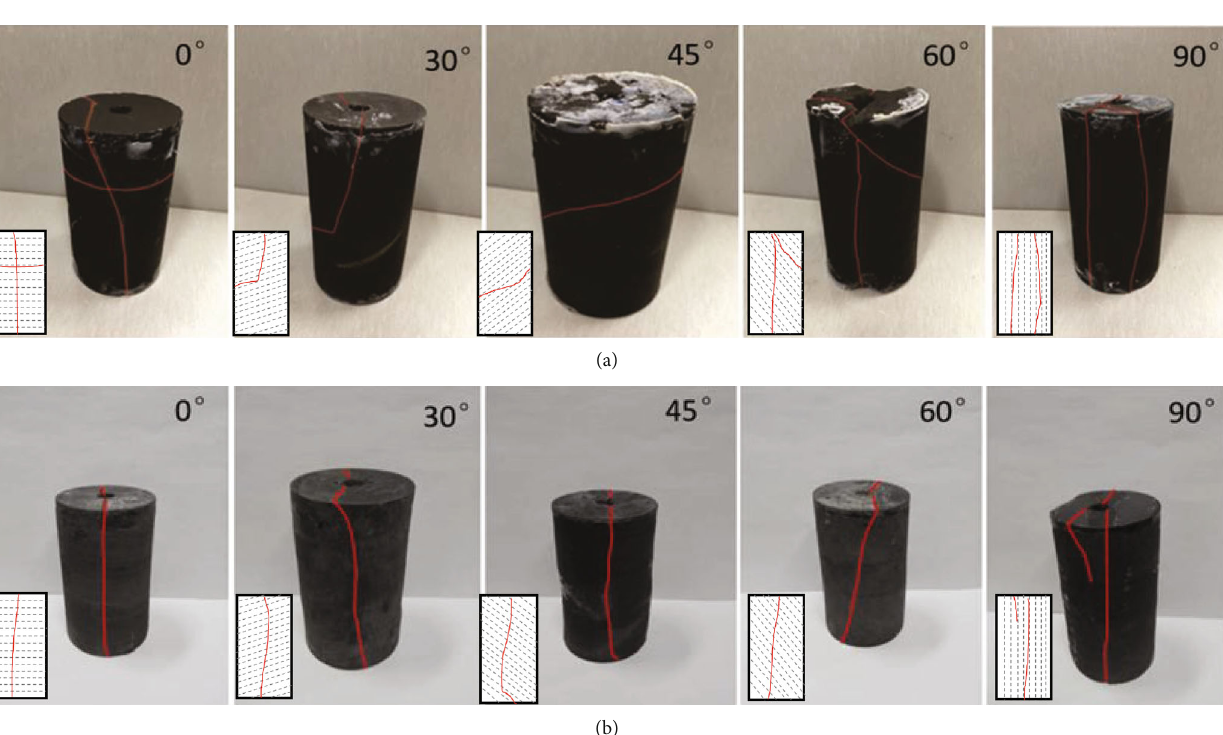
. (The left-bottom diagrams show 2